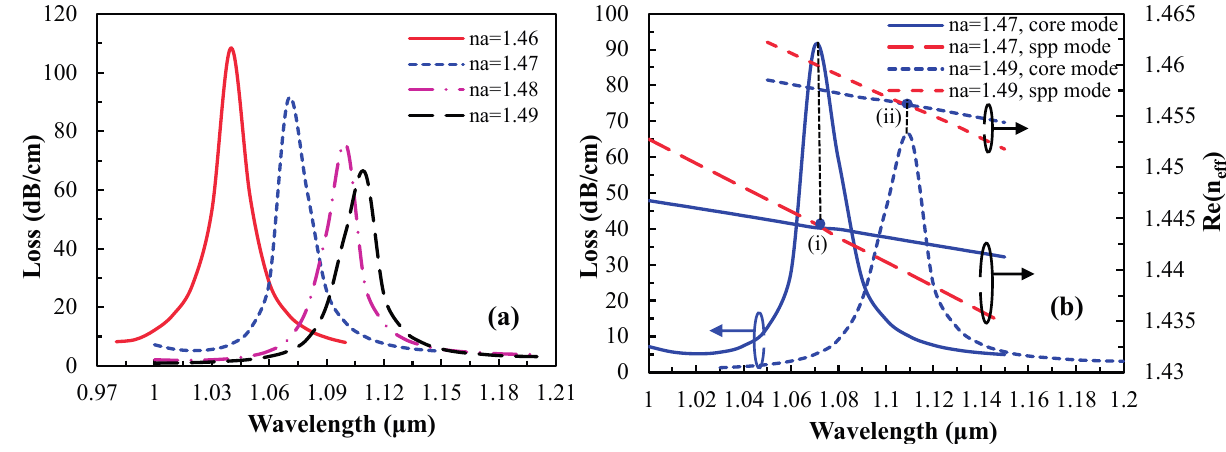
Figure 3. ( a ) Loss spectrum of the fundamental mode by increasing analyte RI, n a , from 1.46 to 1.49; ( b ) dispersion relation of the core-guided mode for n a = 1.47 (solid lines) and n a = 1.49 (dashed lines). Red and blue lines indicate SPP mode and the fundamental core-guided mode respectively. Point (I) and (II) are the phase matching points for analyte n a = 1.47 and